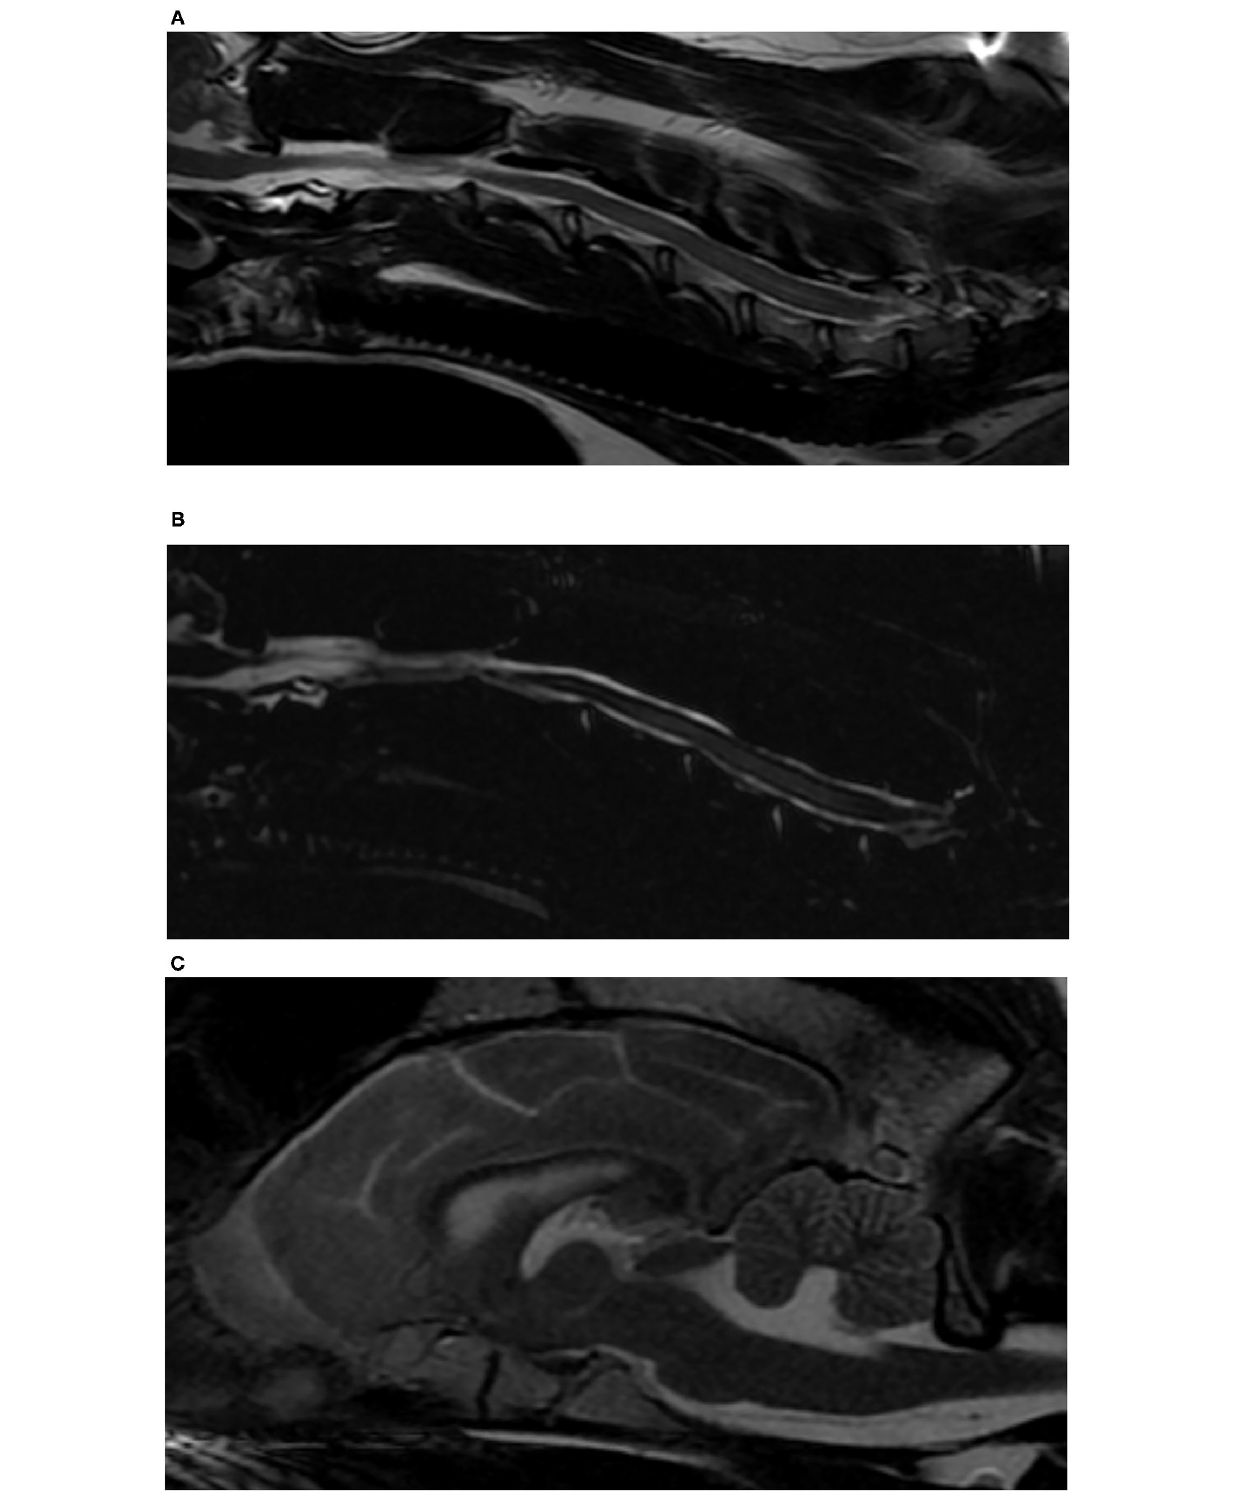
FIGURE 2 | Magnetic resonance images of a dog with Bordetella bronchiseptica meningoencephalomyelitis. (A) Sagittal T2-weighted image of the cervical spinal cord. Note the intramedullary hyperintensity at the level of C4–C6 vertebral bodies and the mildly enlarged central canal at the level of C6 vertebral body. (B) Sagittal MYELO haste image of the cervical spinal cord. Note the thinning of the dorsal subarachnoid CSF column at the level of C5 vertebral body, and the previously described intramedullary hyperintensity. (C) Sagittal T2-weighted image of the brain. Note the enlarged ventricular system.